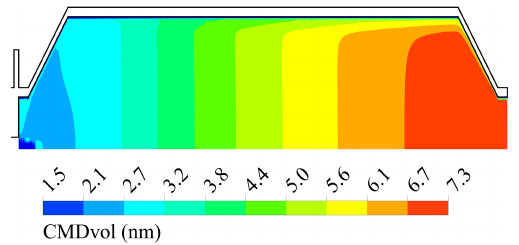
Figure 9. The volatile nucleation mode CMD in the aging chamber region when there is [ H 2 SO 4 ] = 1 . 47 × 10 11 cm − 3 in raw exhaust of R case with n sa = 0 . 25. The figure is scaled vertically with a factor of 10.